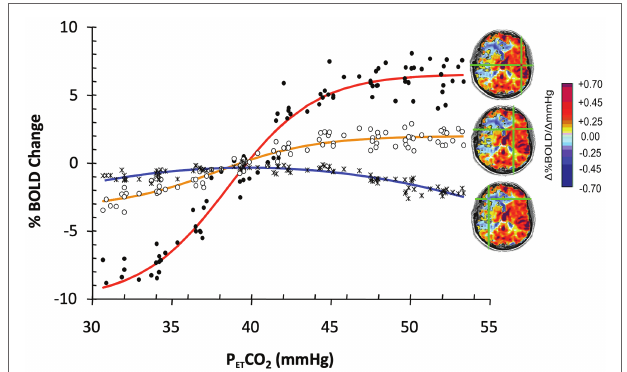
FIGURE 1 | The effect of progressive weakening of vascular response to PaCO 2 on the calculation of cerebral vascular reactivity (CVR). Data show blood oxygen-level-dependent (BOLD) responses to a range of P ET CO 2 in selected ROI in an 18-year-old male with moyamoya disease affecting predominantly the right MCA territory. With progressively weaker vascular responsiveness, the sigmoid relationship (red curve from healthy cortex) weakens, the slope flattens (yellow curve, from moderately compromised territory), and finally, flow decreases instead of increases (steal: blue curve, severely compromised territory) in favor of the more robust vascular beds. Overall fitting a straight line to the data between P ET CO 2 40 and 50 mmHg results in a good fit for the red and yellow lines, less so for the biphasic blue line with slope depending on baseline and the highest PaCO 2 . Modified from Sobczyk et al.